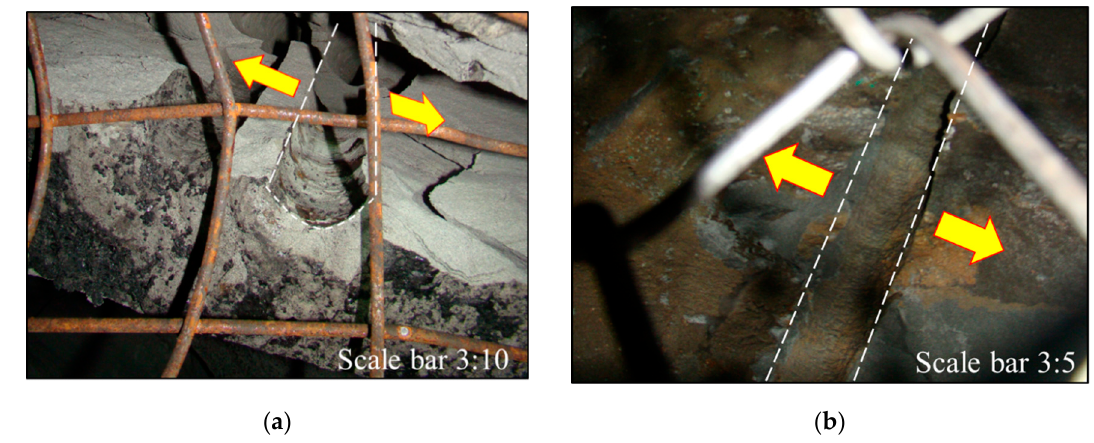
Figure 11. Roof splitting effect shown in the gob. ( a ) Jointed rock mass; ( b ) intact rock mass.